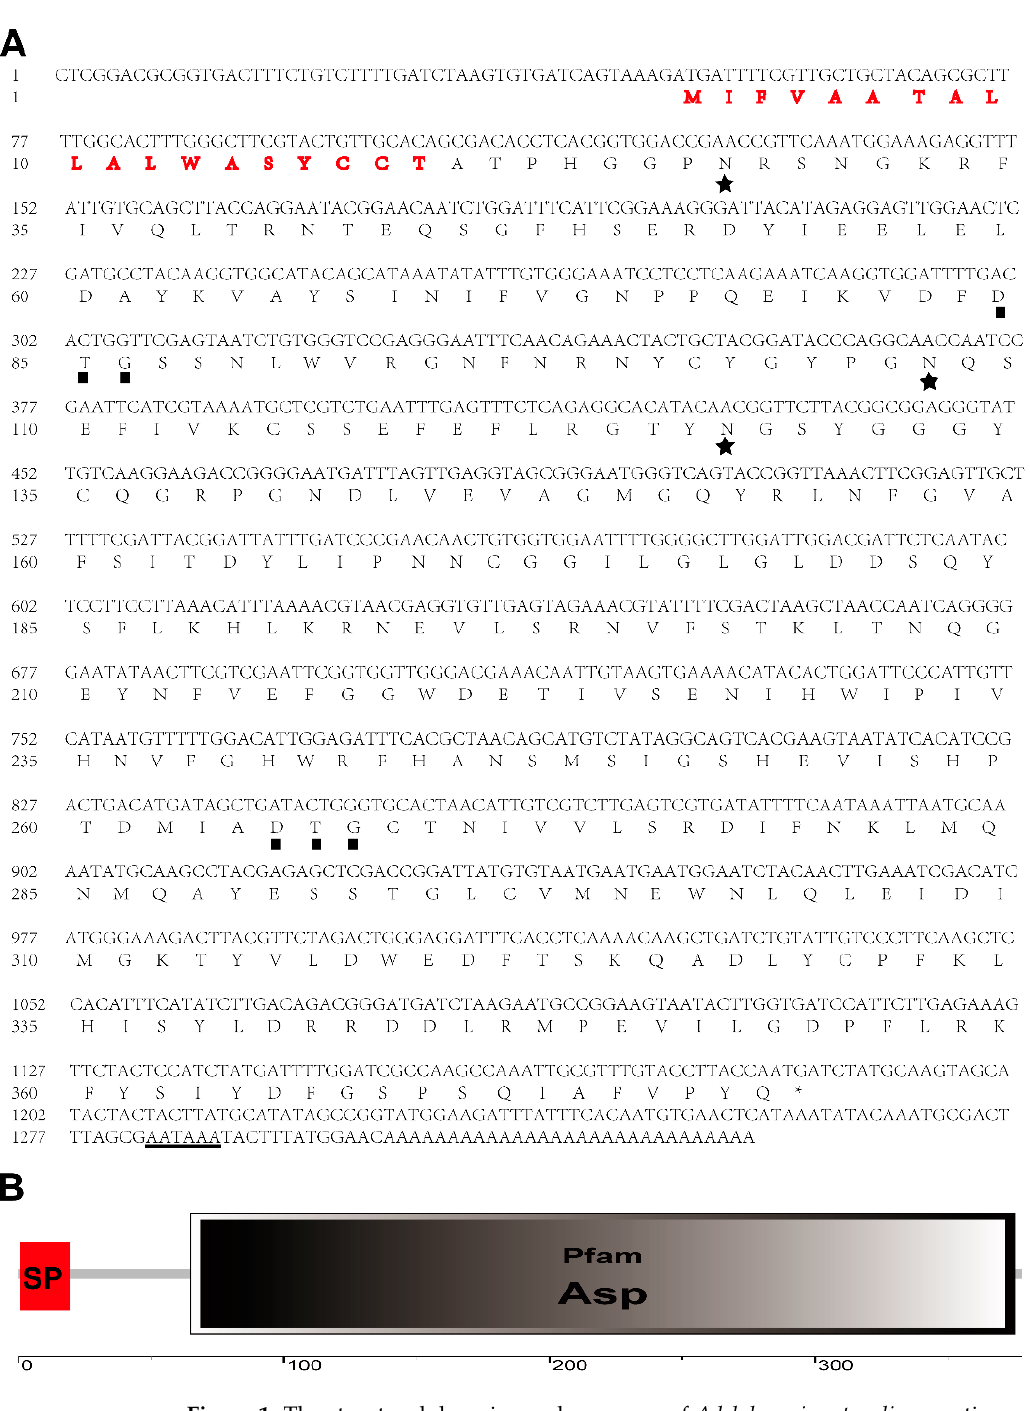
Figure 1. The structural domains and sequence of Adelphocoris suturalis aspartic proteases ( AsAP ): ( A ) the nucleotide and deduced amino acid sequence of AsAP with the putative signal peptide indicated by red letters, the potential N -glycosylation sites indicated by stars, the amino acids (DTG) comprising conserved catalytic sites indicated by solid squares and the putative polyadenylation signal (AATAAA) indicated by the underline; ( B ) a schematic diagram illustrating the functional domains of AsAP. SP: signal peptide; Asp: aspartic domain.